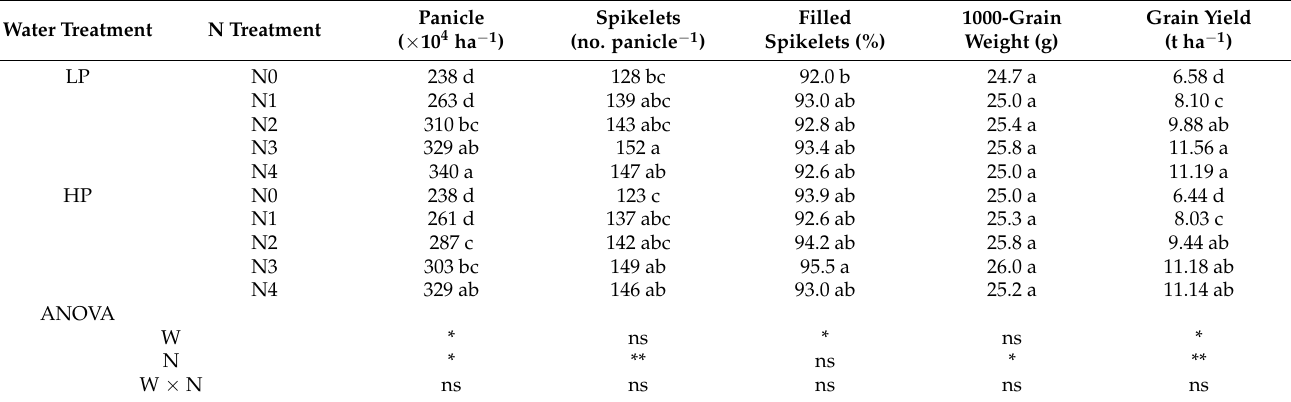
Table 3. Grain yield and yield components under various water and N treatments.